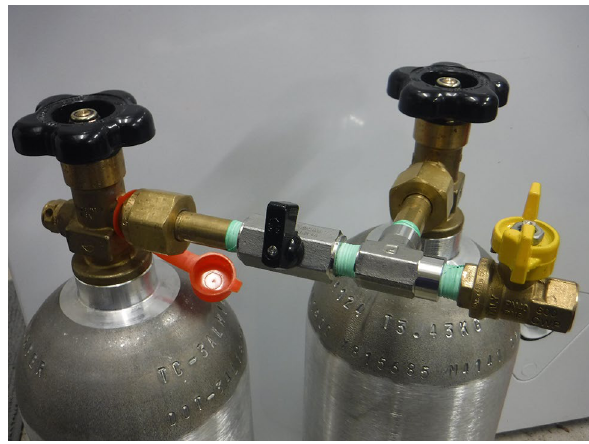
Figure 1. The manifold to connect the two 3.4 liter CO 2